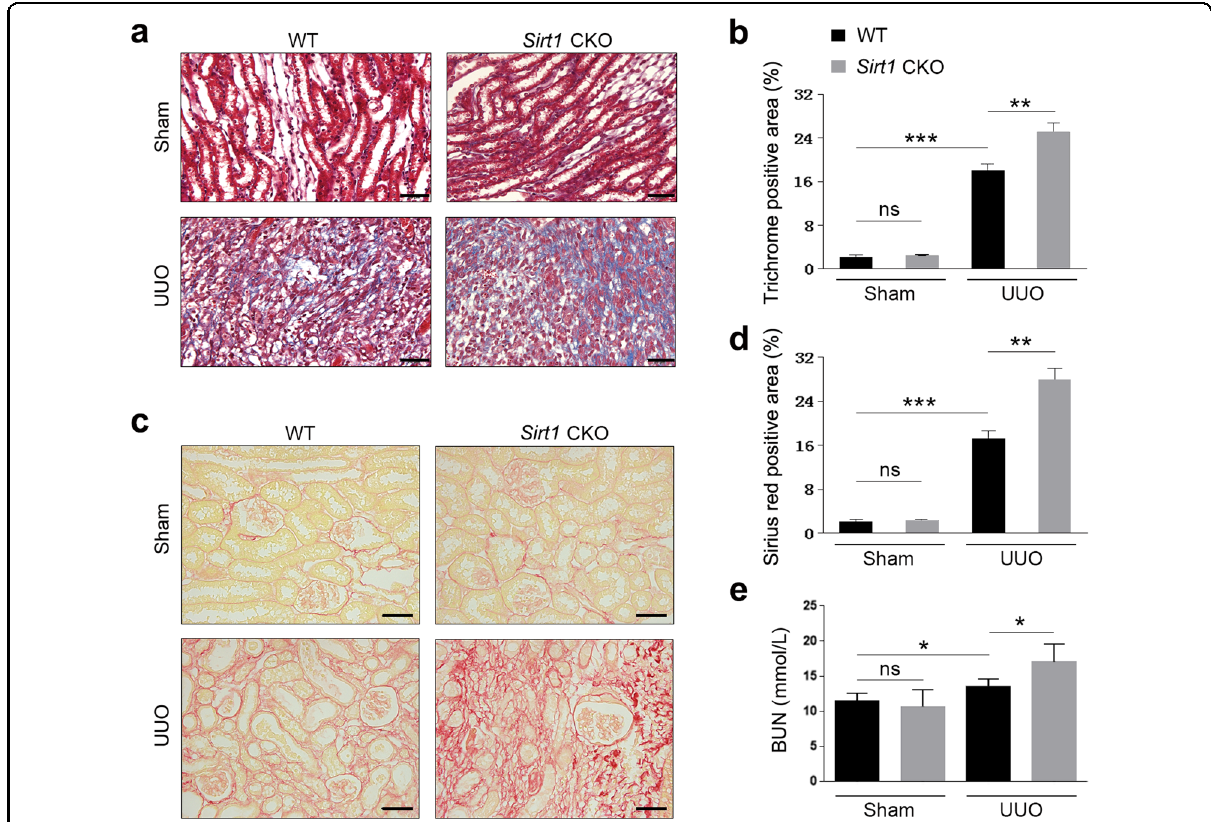
Fig. 3 Renal interstitial cell-speci fi c ablation of Sirt1 enhances fi brogenesis during UUO injury. Male WT ( Sirt1 fl ox/ fl ox ) and Sirt1 CKO ( Sirt1 fl ox/ fl ox/TNCCreER ), at 8 – 10 weeks of age, were subjected to UUO operation. Mice were sacri fi ced on the 10th day after sham or UUO surgery. a Paraf fi n section from kidneys of sham or UUO surgery mice was analyzed by Masson-trichrome staining. Scale bar = 20 μ m. b Quantitative analysis of Masson-trichrome staining. c Sirius red staining. Scale bar = 20 μ m. d Quantitative analysis of Sirius red staining. e BUN levels. n = 6. Data are means ± SEM; ns: no signi fi cance. * P > 0.05, ** P < 0.01, *** P <